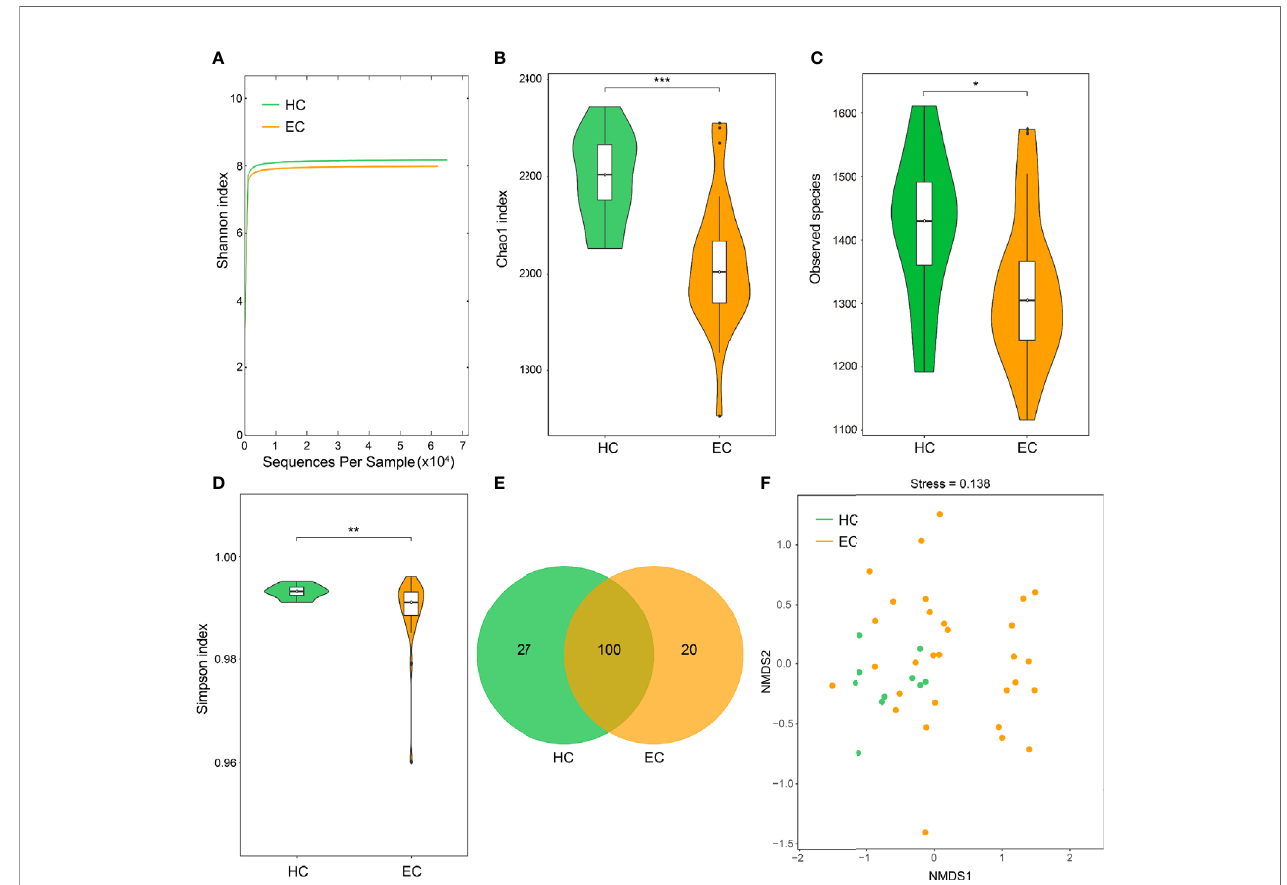
FIGURE 1 | Endometrial microbial diversity of HC and EC participants. (A) Shannon-Wiener rarefaction curve of HC and EC groups. (B – D) a -Diversity comparison between different disease states in the endometrial microbiome. (B) , Chao1 index; (C) , observed species; and (D) , Simpson index. * p < 0.05, ** p < 0.01, *** p < 0.001, Wilcoxon rank sum test. (E) Venn diagram illustrating the shared and unique genera between HC and EC. (F) Beta diversity evaluated using NMDS with an unweighted UniFrac distance matrix. HC, healthy control; EC, endometrial